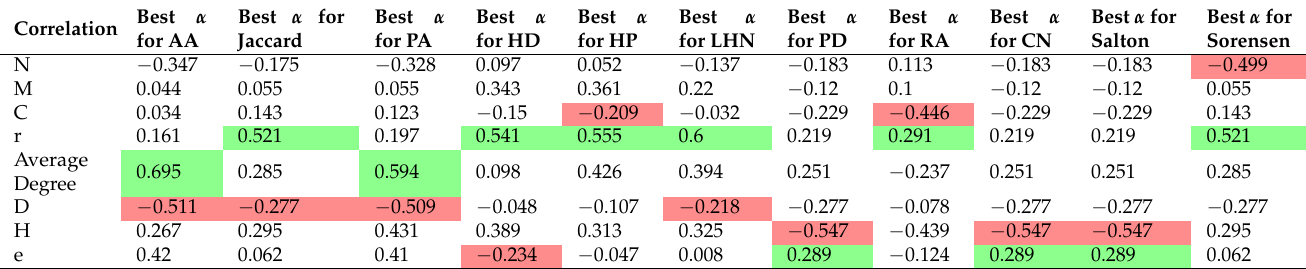
Table 5. Correlation between the best α of each algorithm and the network